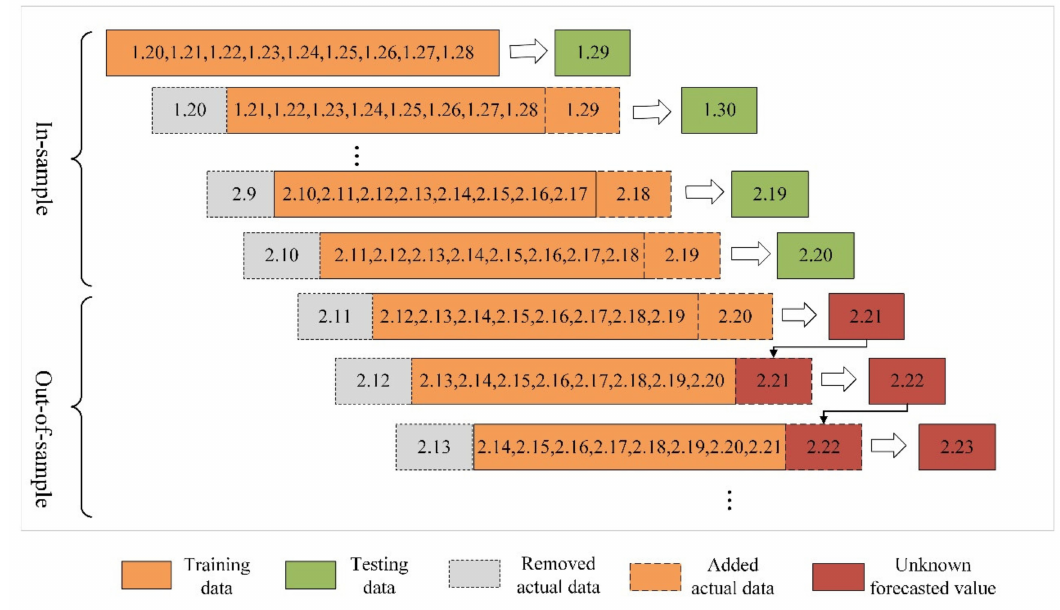
Figure 4. The rolling mechanism of the rolling grey Verhulst